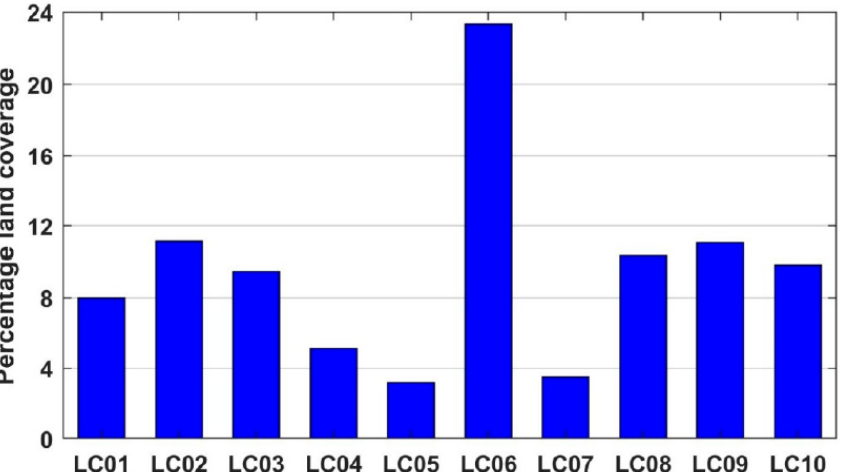
Figure 1. Percentage global land coverage of ten land cover types: namely, tropical/sub-tropical evergreen broad-leaved forest (LC01), deciduous forest (LC02), evergreen broad-leaved and needle- leaved forest (LC03), deciduous woodland (LC04), sclerophyllous woodland and forest (LC05), wooded and non-wooded grassland (LC06), tundra and mossy bog (LC07), boreal and xeromorphic shrubland (LC08), non-vegetated desert (LC09), and ice